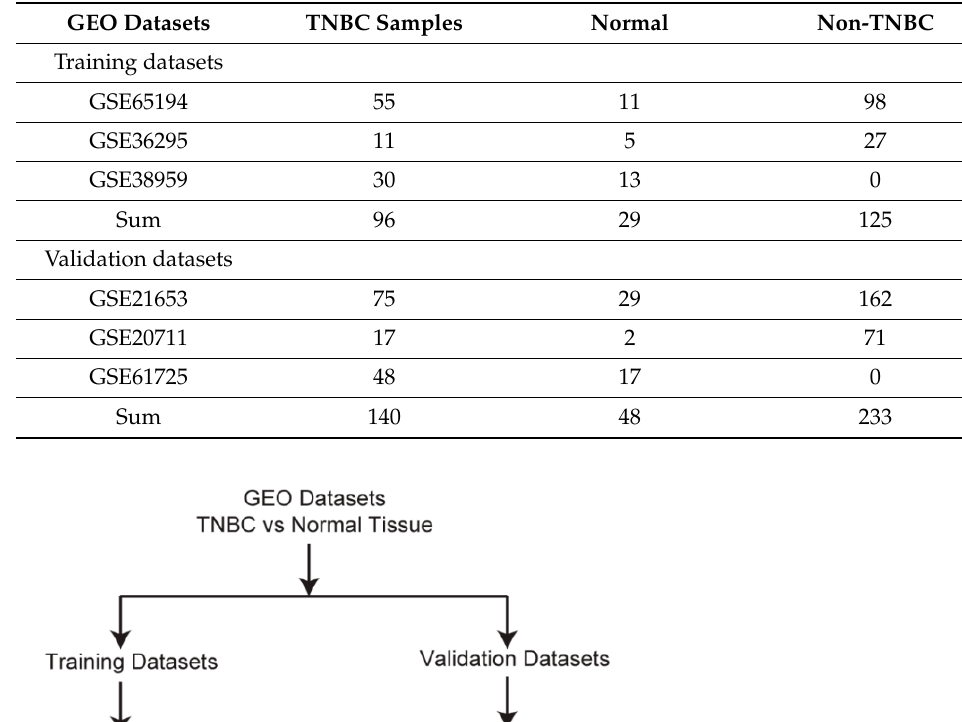
Table 1. The dataset compositions.